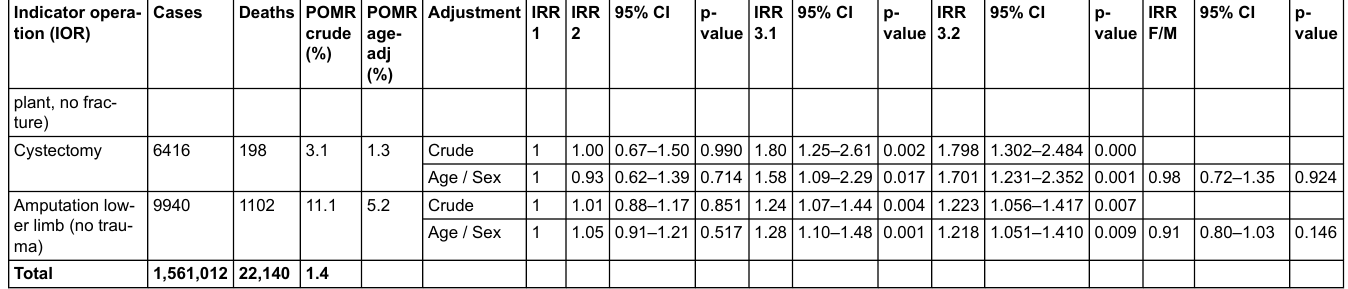
Figure 2: Unchanged POMR trends in low-risk IORs.Note: POMR = perioperative mortality rate. Sex-specific analyses were not com- pleted for sex-specific operations (hysterectomy, TUR prostate; see methods section). Note that different percentage scales are used for the upper three and the lower three